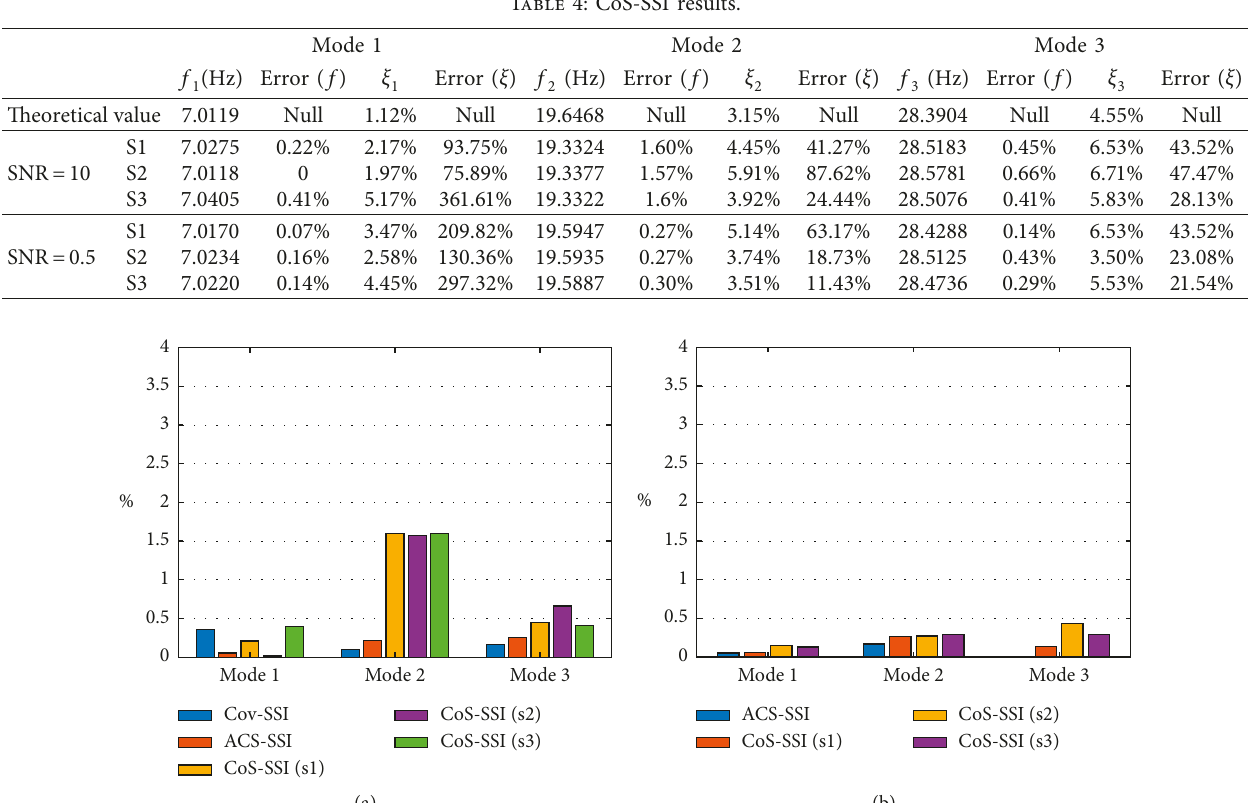
Figure 8: Identified frequency errors. (a) Identified frequency errors (SNR